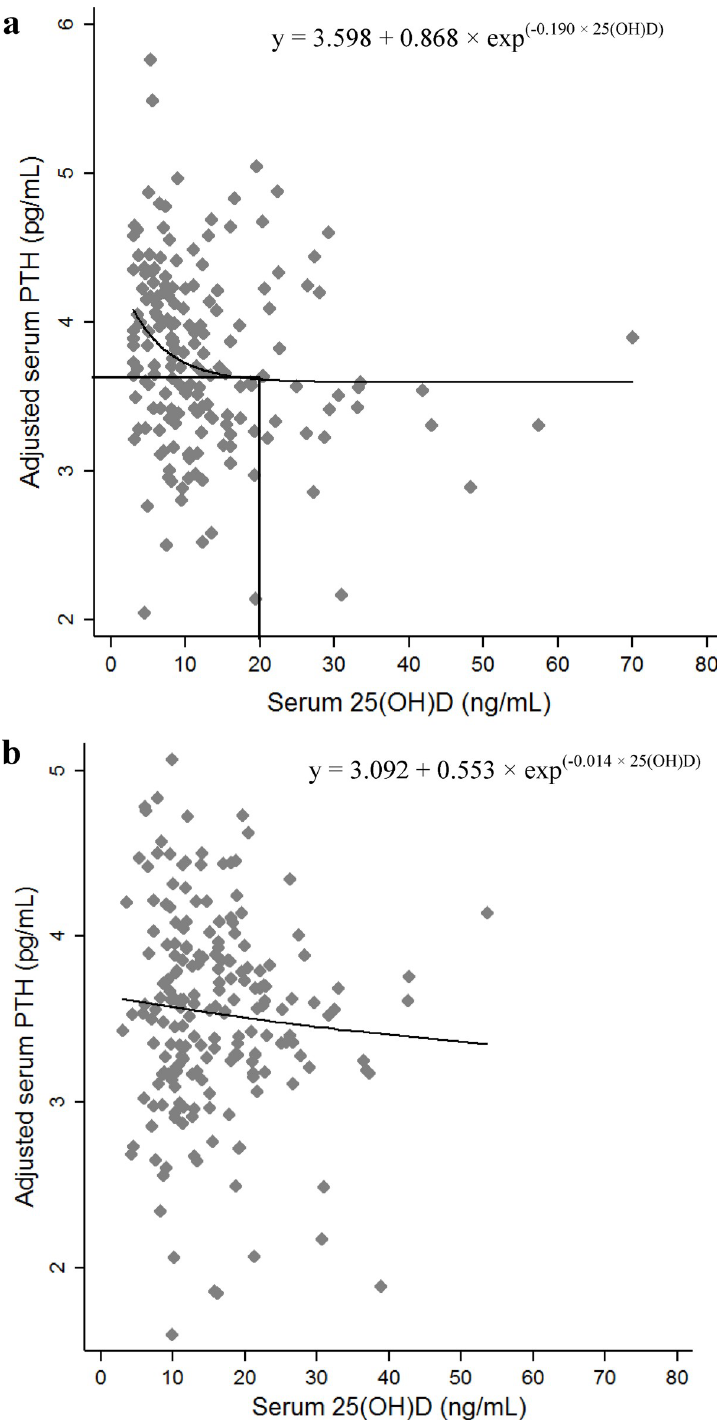
Fig 1. Association between serum 25(OH)D and adjusted log-transformed iPTH concentrations using nonlinear regression analysis. (a) females; (b) males.